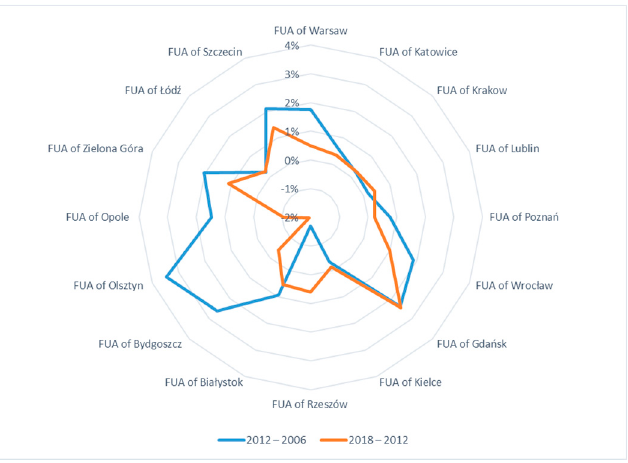
Figure 3. The NUASI changes between 2018 and 2012, as well as 2012 and 2006.